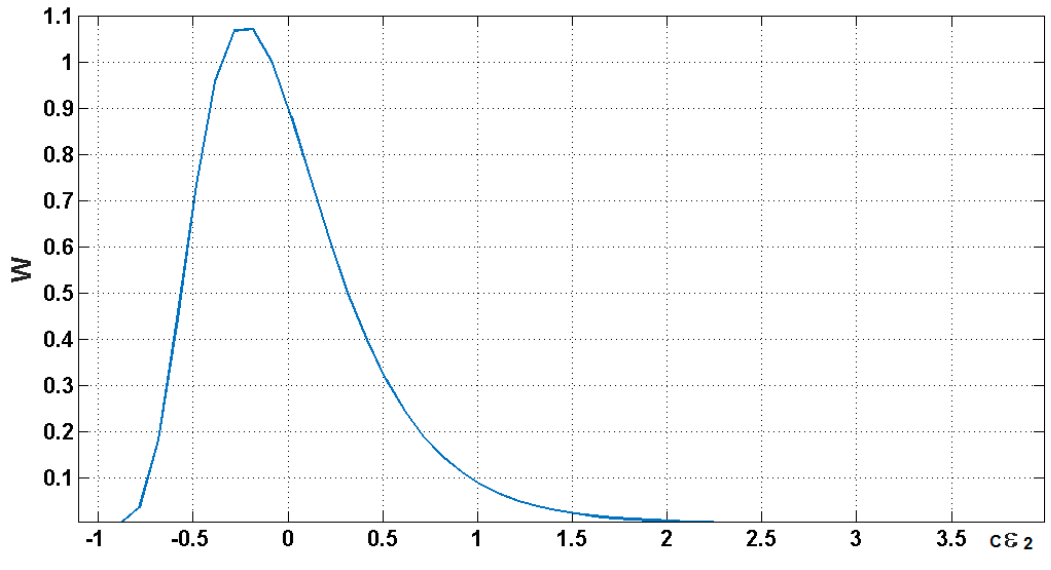
Figure 7. Probability density of the log-normal distribution of fluctuations ε 2 ( r ), c = 0.45 / σ 2 .